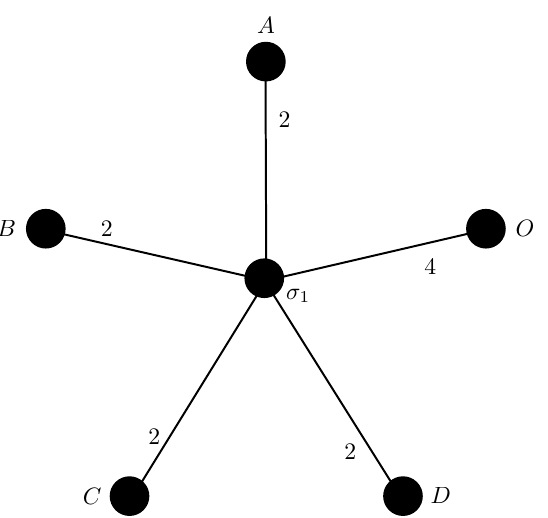
Figure 16 . A graph with four boundary vertices A, B, C, D and purifier O along with one internal vertices σ . Edge capacities are labeled for each 1